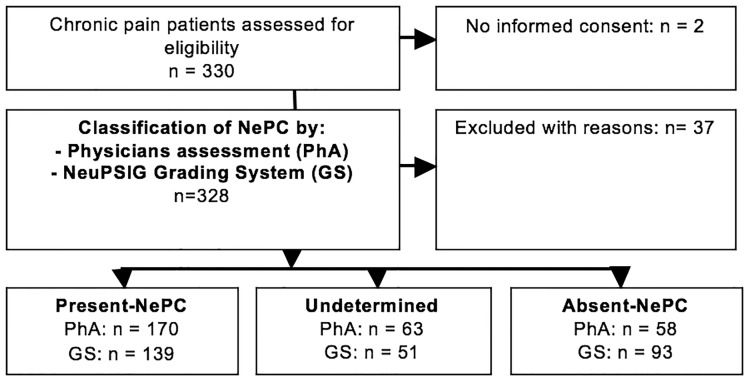
Flow diagram for the outcome of the physicians assessment and the NeuPSIG grading system.Present NePC: present neuropathic pain component; Undetermined: Both physicians disagree with each other about the existence of a neuropathic pain component; Absent NePC: absent neuropathic pain component; n = total number of patients in analysis PhA: Physicians assessment; GS: Neuropathic pain special interest group grading system (missing pain classification based on the grading system: n = 8).